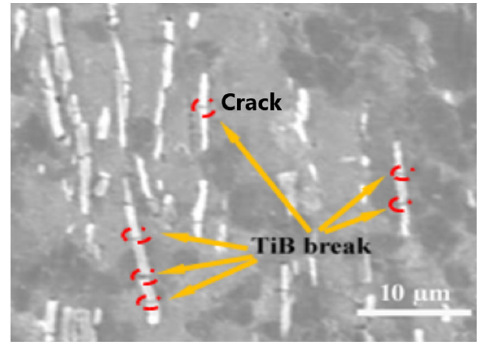
Figure 9. Breakage of TiB fibers during thermal processing.